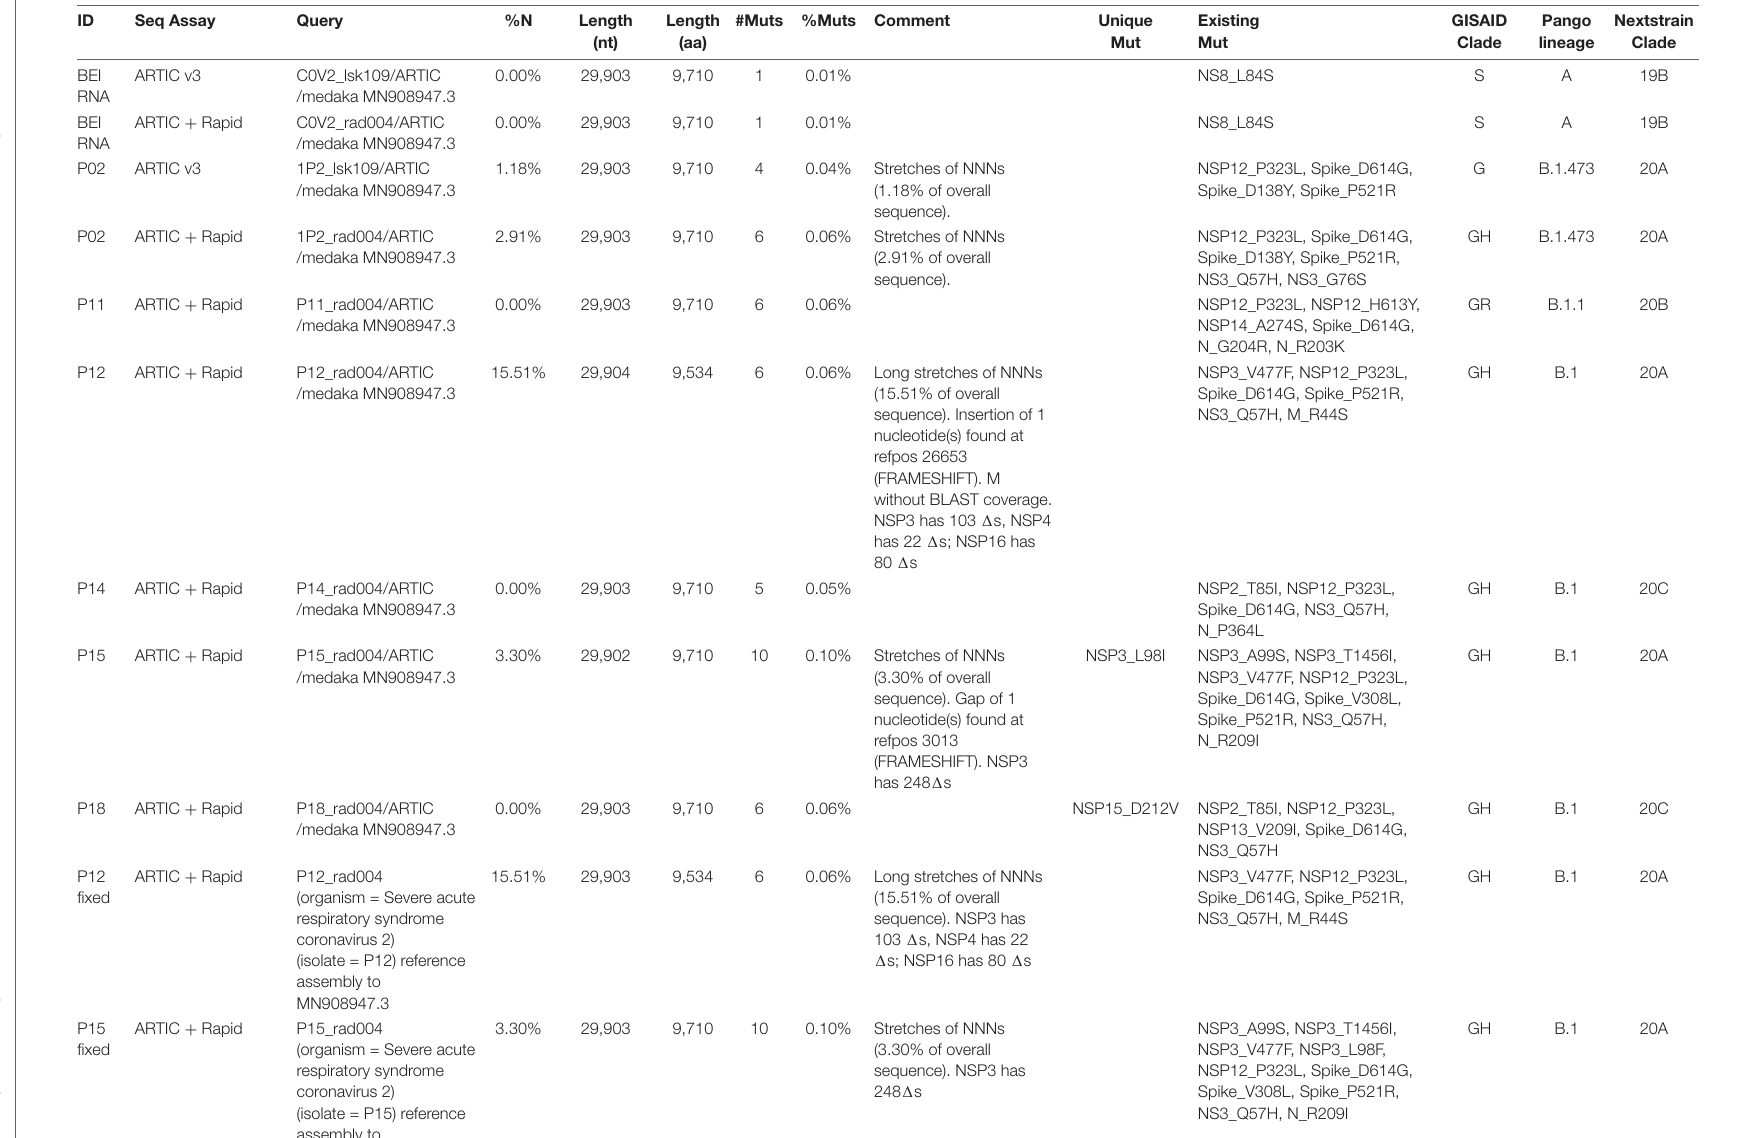
TABLE 5 | Mutation analysis of assembled sequences using CoVsurver and comparison to Pangolin and Nextclade